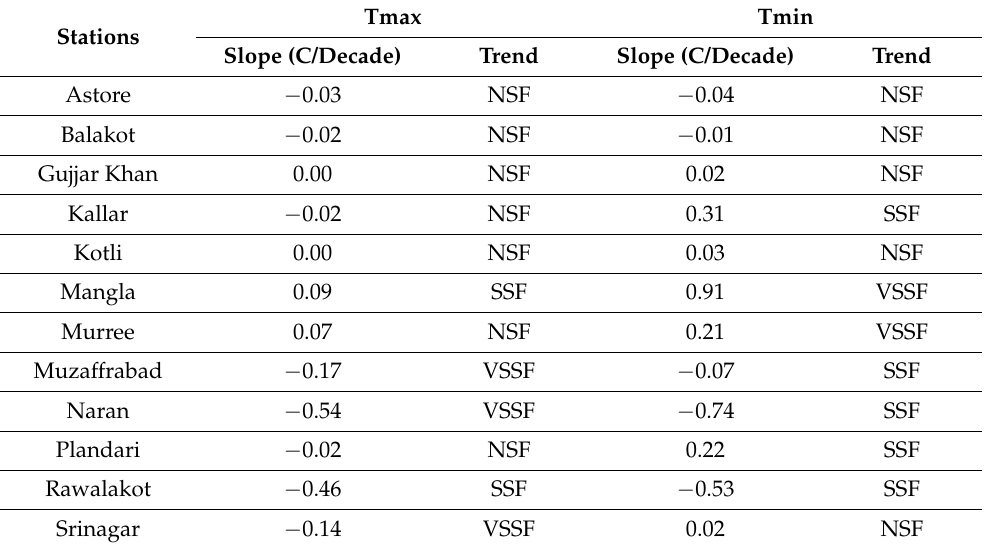
Table 3. Annual max. and min. temperature slopes and